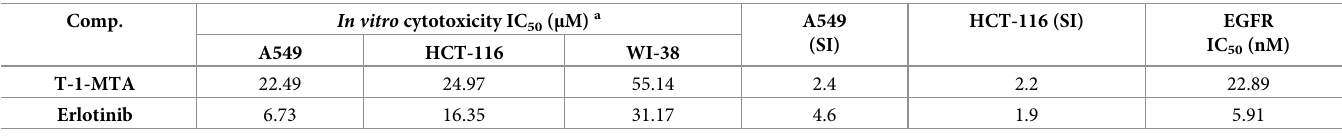
Table 5. In vitro anti-proliferative activities of T-1-MTA.